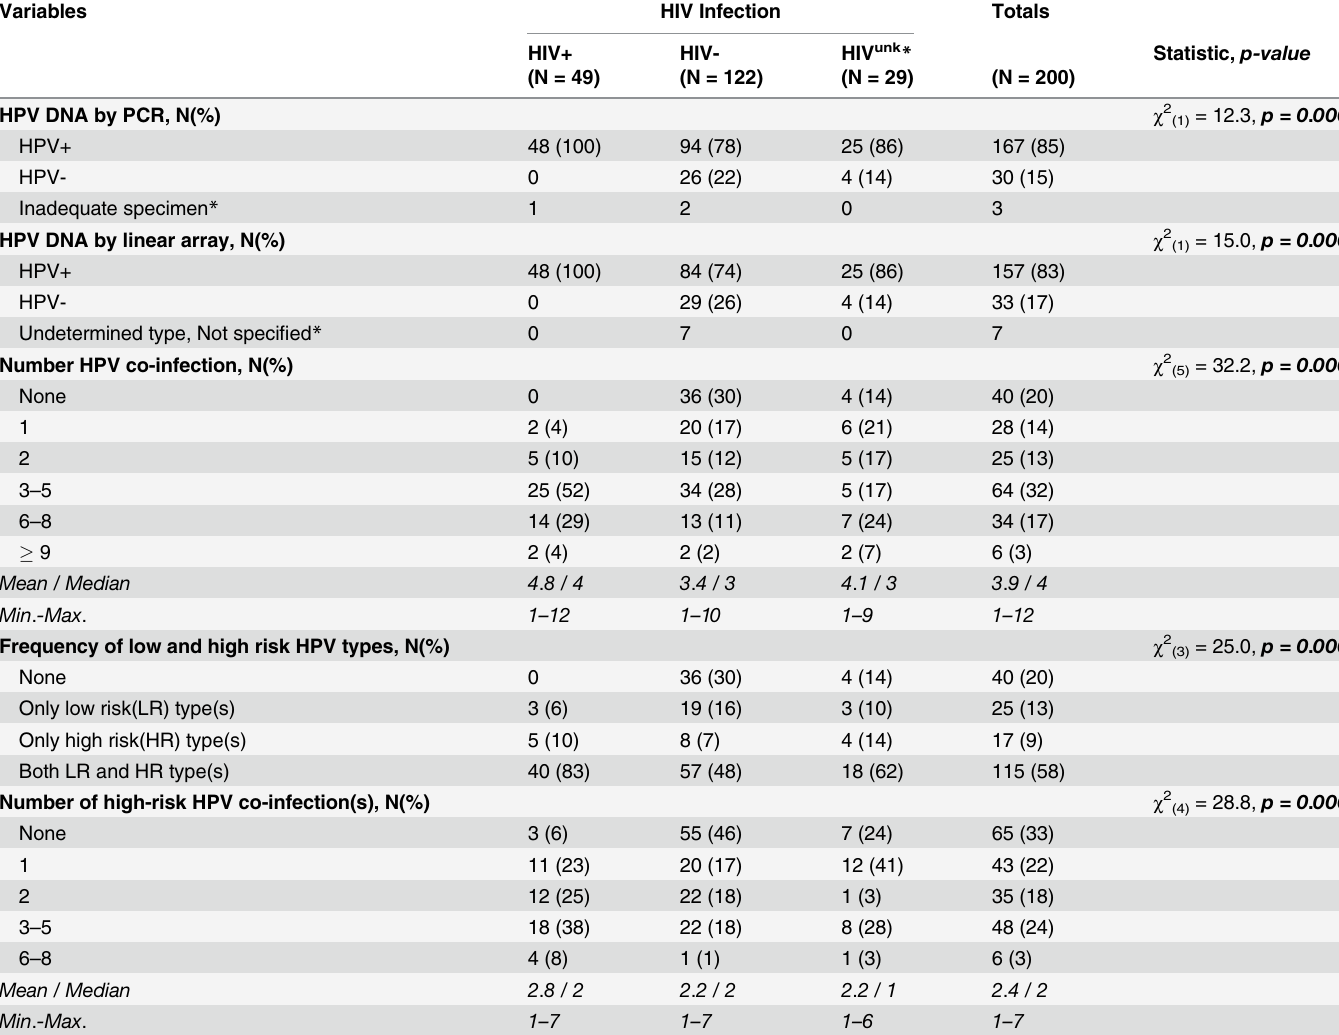
Table 3. HPV infections and co-infections by HIV infection status of MSM subjects studied in Chiang Mai, Thailand, 2012 – 2013.